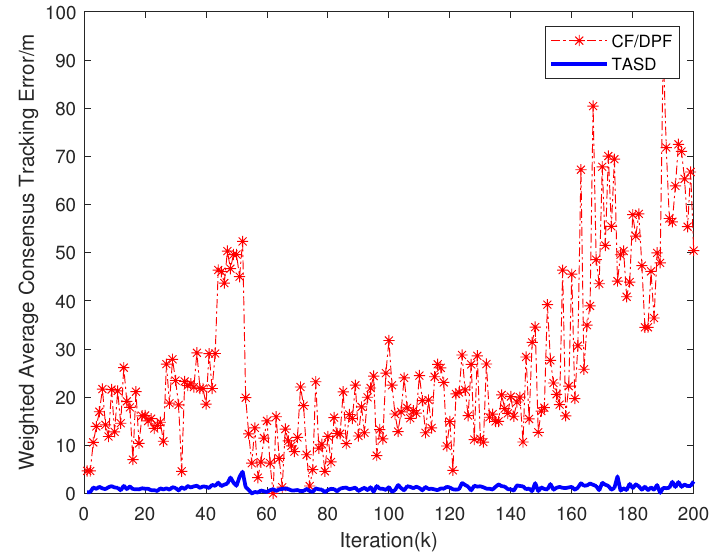
Figure 9. Weighted consensus tracking errors in a large-scale sparse and dynamic